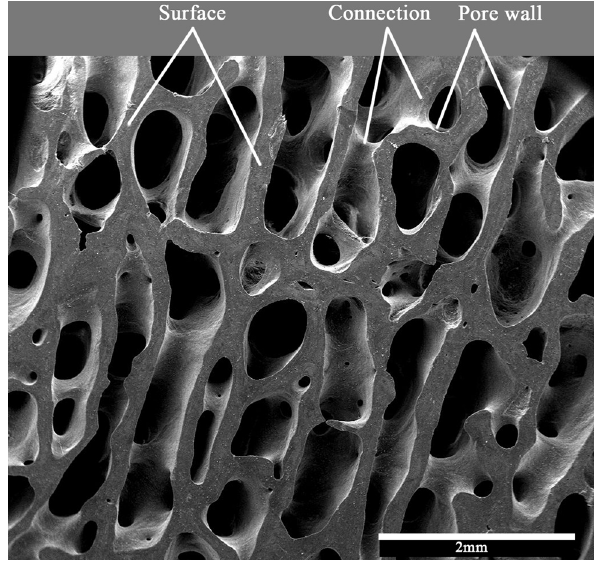
Figure 2: The microstructure morphology of the bone slice under SEM and the structures are divided into three typical